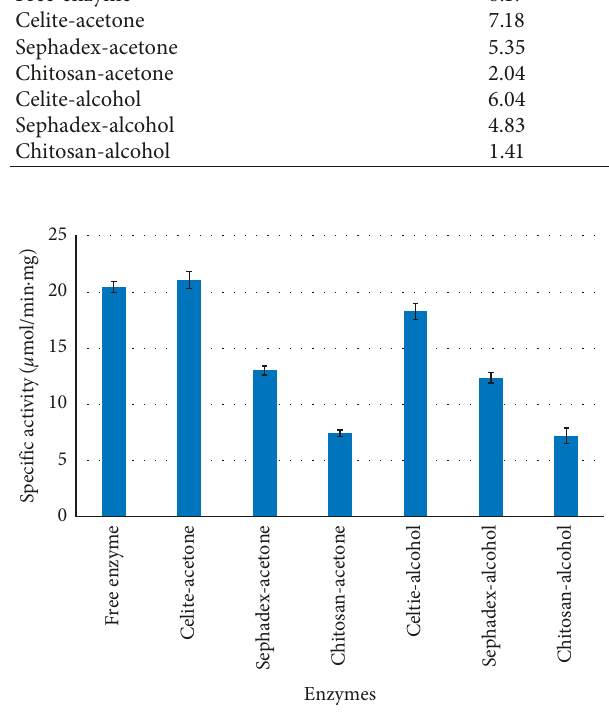
Figure 1: Graphical representation of specific hydrolytic activities of all enzymes (pH 7.0, temperature 45 ° C, and [S]